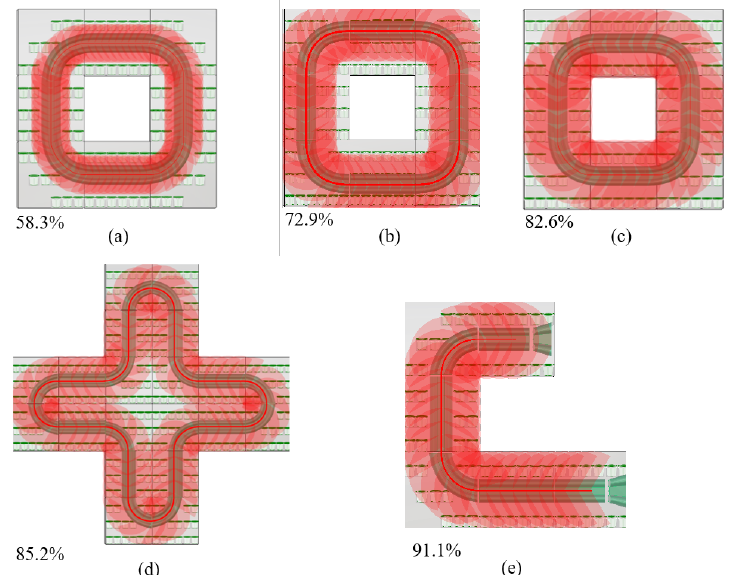
Figure 12. Robot reachability evaluation for vertical garden layouts that do not follows the proposed design guidelines. The robot reachability of each case is overlaid in shaded color. The resultant percentage pot reachability is given under each case. The track height is 10 cm for all the cases other than ( a ). It should be noted that the figures are not in the same scale. ( a ): The track height is designed not according to the guidelines. Track height is 25 cm. ( b , c , e ): The plot placing is not according to the guidelines. ( d ): An open track